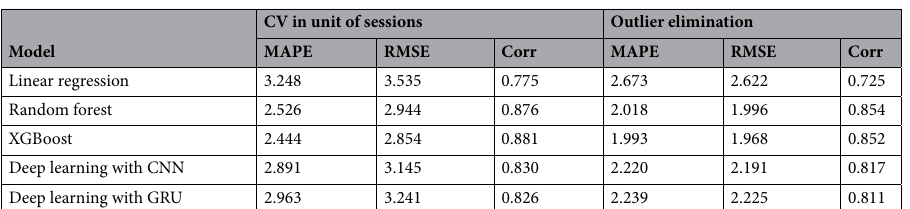
Table 3. Sensitivity analysis results for the cross-validation of units as hemodialysis sessions and outlier elimination. Models were trained through age, gender, dialyzer surface area, dialysis pre-weight, height, dialysis pre-BUN, hemodialysis type (conventional hemodialysis or hemodiafiltration), and the artificial features of BFR, dialysate flow rate, and ultrafiltration volume. CV cross-validation, MAPE mean absolute